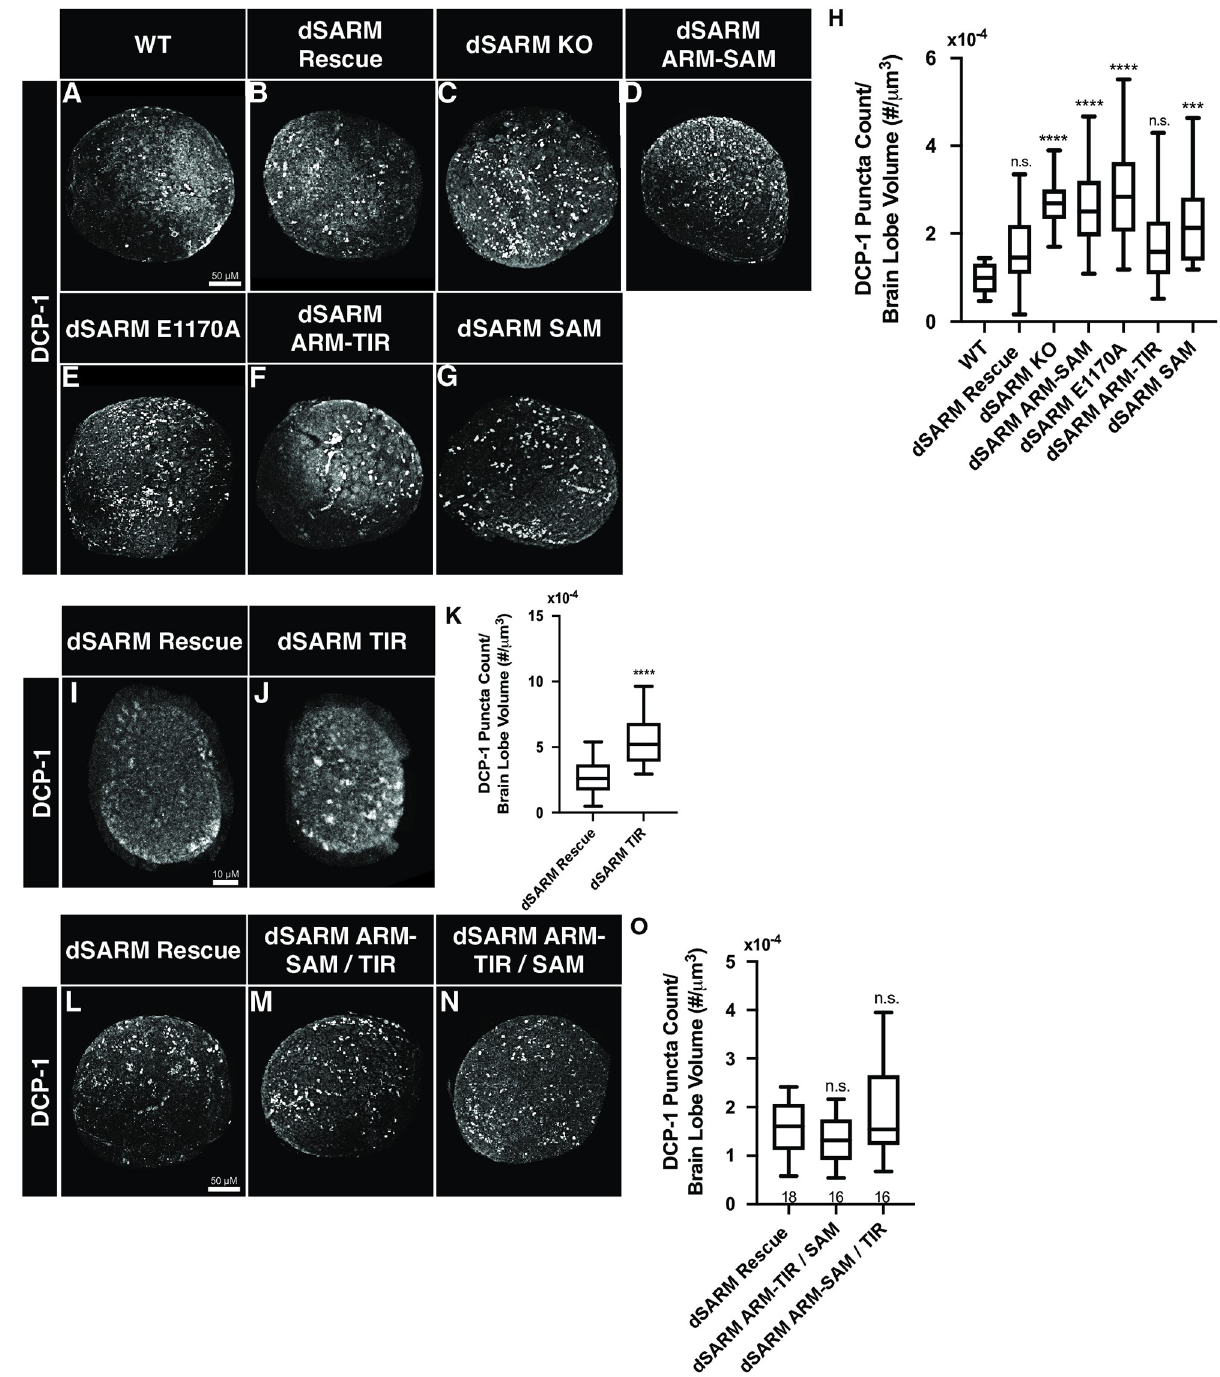
Fig 6. dSARM signaling in glia requires its NADase activity, but not its SAM domains. (A-G, I-J, and L-N) Representative z-projections of brain lobes of the indicated genotypes labeled with anti-Dcp-1. (H) Quantification of the number of Dcp-1 puncta normalized to brain lobe volume: wild type (Oregon R) (n = 28): 9.82x10 -5 , dSARM Rescue (n = 80): 1.64x10 -4 , dSARM KO (n = 30): 2.73x10 -4 , dSARM ARM-SAM (n = 20): 2.69x10 -4 . dSARM E1170A (n = 28): 2.91x10 -4 , dSARM ARM-TIR (n = 38): 1.75x10 -4 , and dSARM SAM (n = 17): 2.35x10 -4 . (K) Quantification of the number of Dcp-1 puncta normalized to brain lobe volume: dSARM Rescue (n = 26): 2.61x10 -4 , and dSARM TIR (n = 34): 5.22x10 -4 . (O) Quantification of the number of Dcp-1 puncta normalized to brain lobe volume: dSARM Rescue (n = 18): 1.57x10 -4 , dSARM ARM-SAM/TIR (n = 16): 1.92x10 -4 , and dSARM ARM-TIR/SAM (n = 16): 1.32x10 -4 . n values can be found on each graph. n.s., not significant; � , p < 0.05; �� , p < 0.01; ��� , p < 0.001; ���� , p < 0.0001.